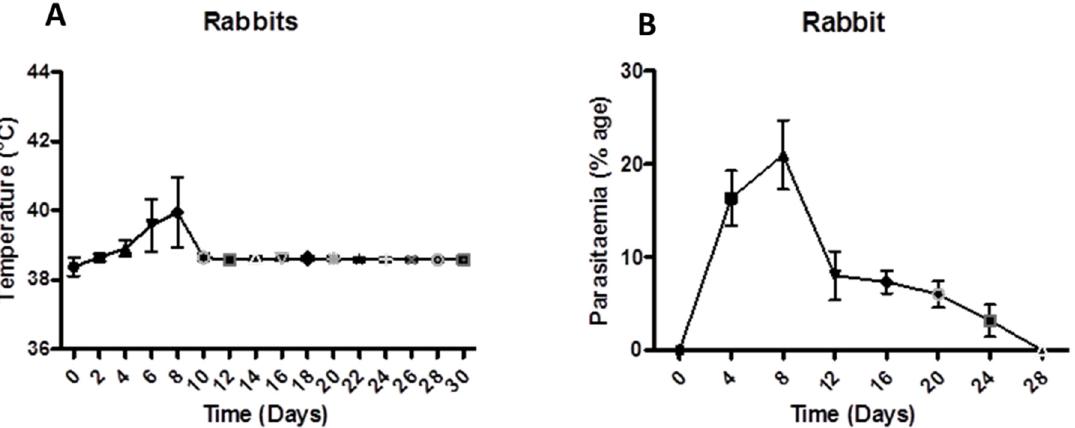
Figure 1. The effect of Babesiosis on body temperature ( A ) and parasitaemia ( B ) in experimental rabbits.